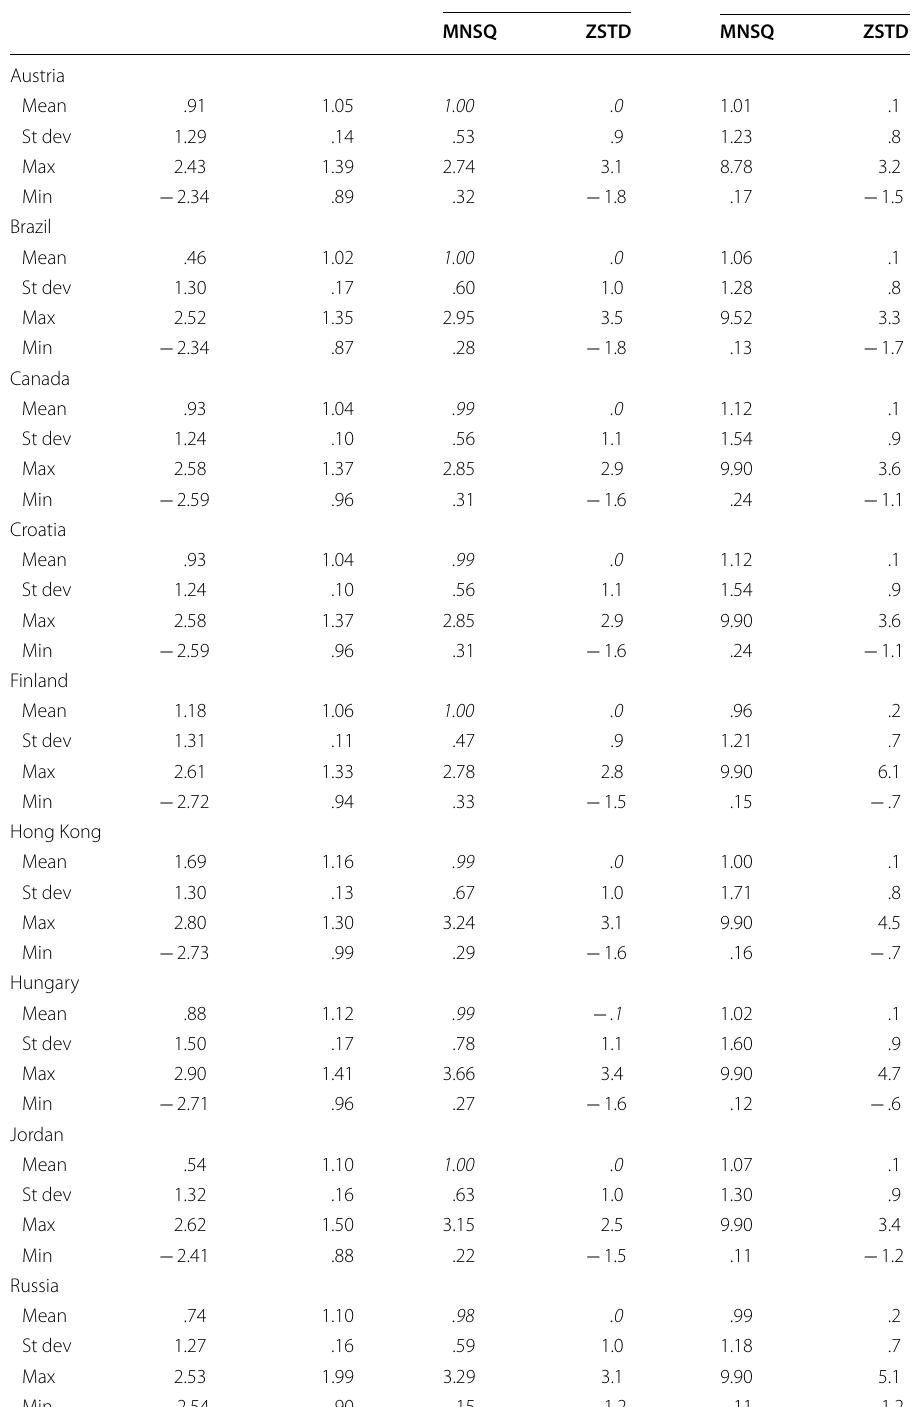
Table 3 Financial knowledge test: summary statistics of Rasch modelling for non‑extreme persons by country. Source: summarised from WINSTEPS ® output (Linacre